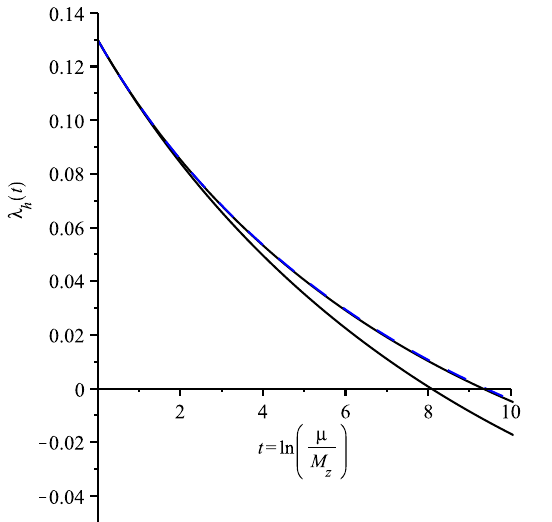
Figure 5 . After the Higgs discovery, all of the initial values are known for the standard model parameters and one can follow the evolution of Higgs self-coupling. The lower line has only one-loop corrections. The line shifts to the right when two-loop effects are added to RG equations, and the tunneling time increases consequently. The blue dashed line includes three-loop corrections and suggests that going to higher orders will not improve the situation.